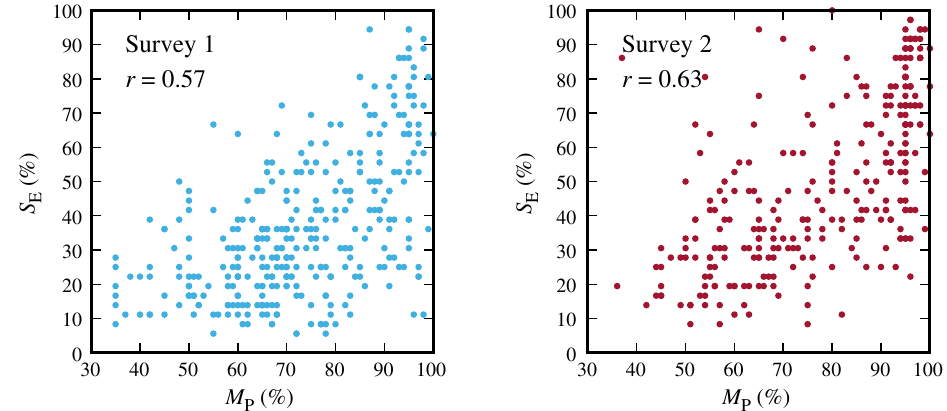
FIG. 2. Scatter plots of epistemic scores ( S Survey 2 in right panel). The Pearson correlation coefficient r is indicated in each